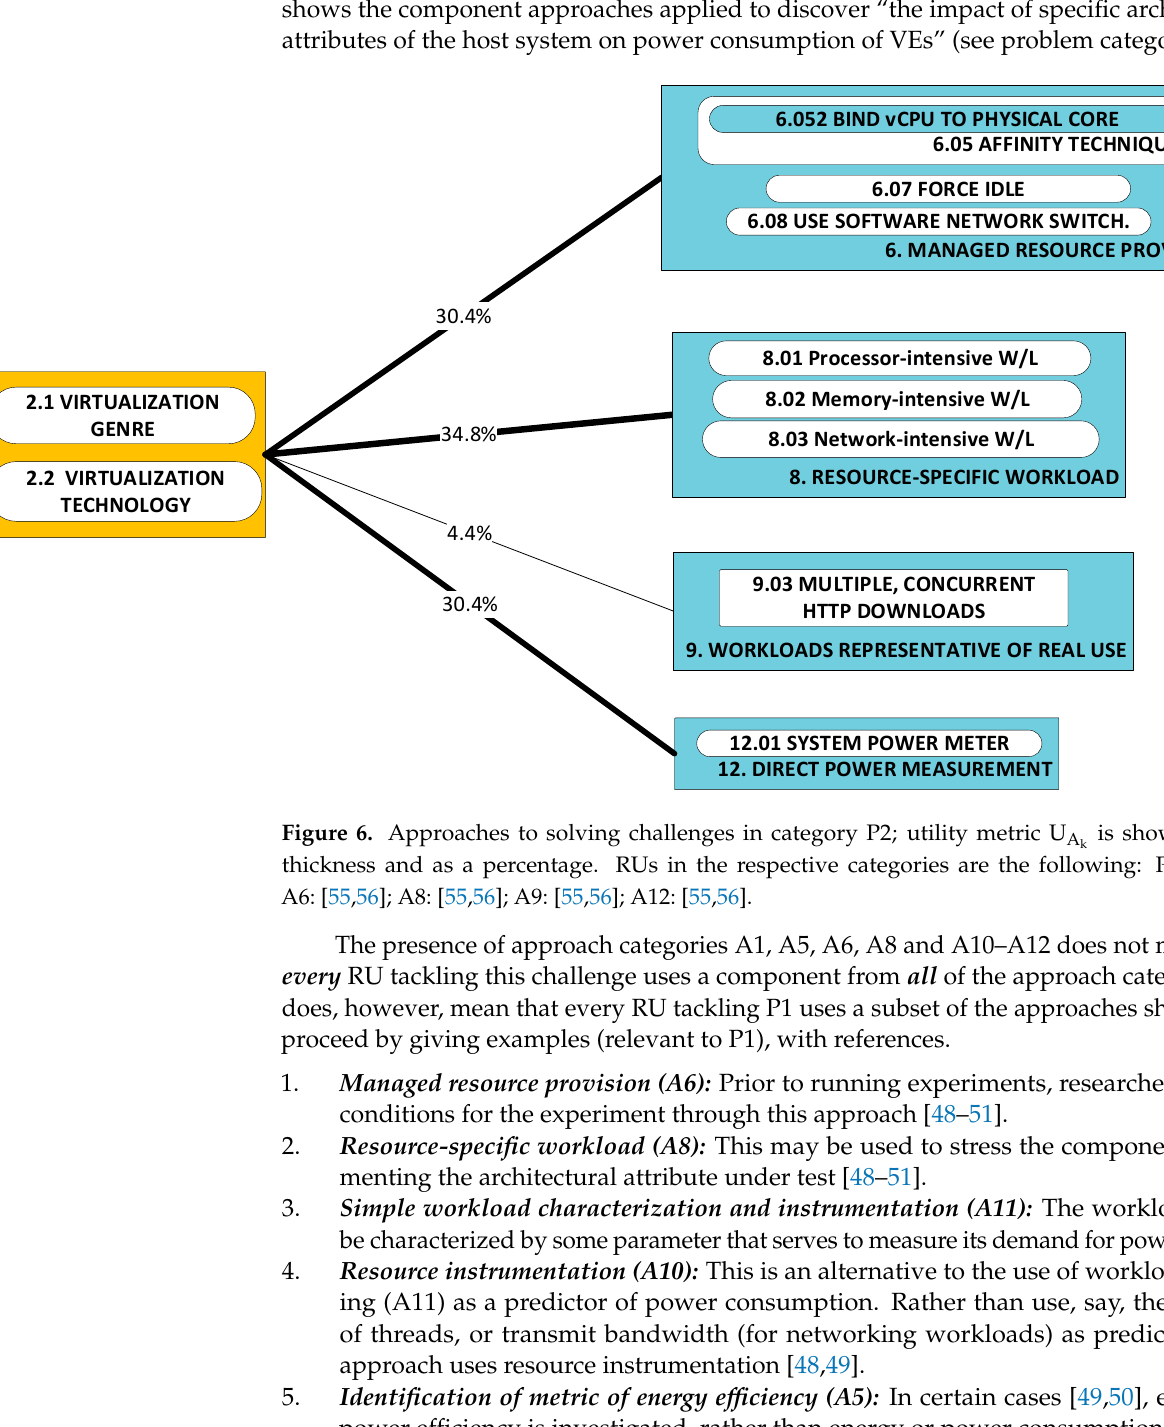
is shown in line is shown in line (cid:3169) k